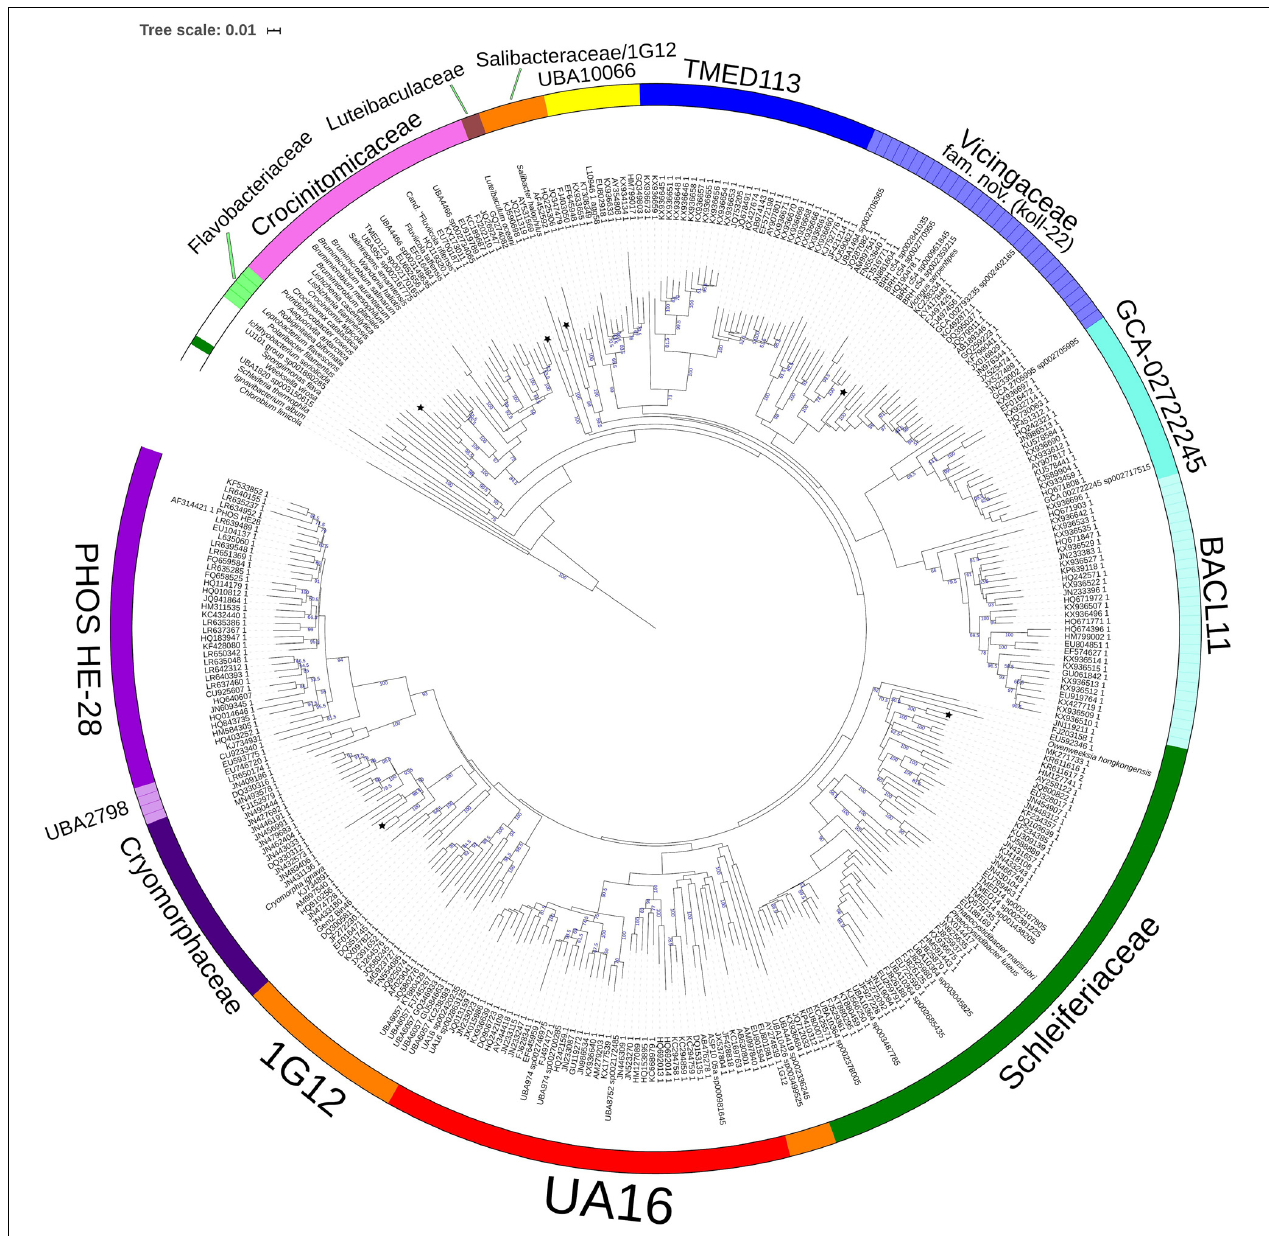
FIGURE 1 | 16S rRNA gene sequence based BioNJ tree focusing on sequences related to the family Cryomorphaceae and related taxa of the order Flavobacteriales , phylum Bacteroidetes . The tree is a consensus tree generated in IQ-Tree. Bootstrap values converted to a percentile scale are based on 1000 replicates determined using the ultrafast method of Hoang et al. (2018). Only bootstraps exceeding 50% are shown. Color strips indicate location of family-level lineages based on the GTDB framework. Family designations include the GTDB and the revised taxonomy determined in this study. Star symbols located on branches indicate validated described type strains relevant to this study. More detailed information on taxa compared is shown in Table 2 and Supplementary Table S1